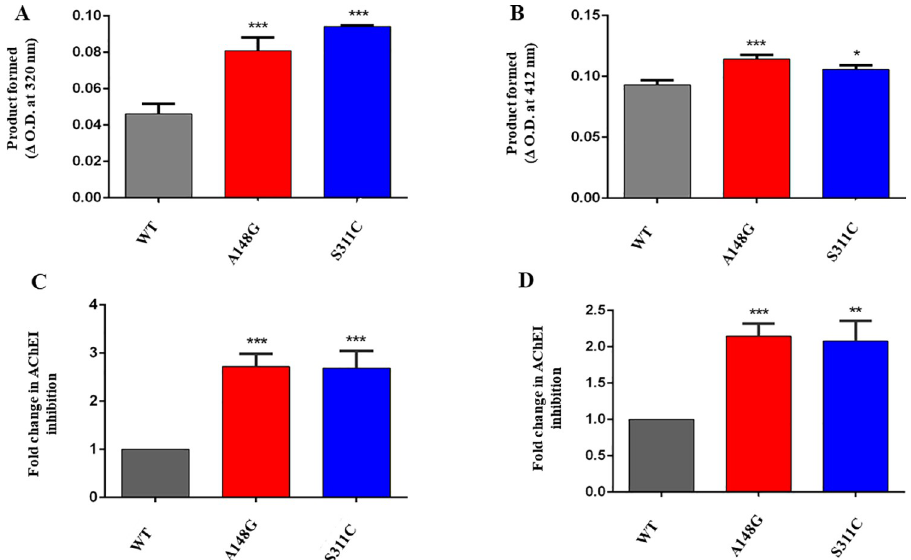
Fig 6. Comparative activities of HuPON2-WT and polymorphic site mutants and corresponding inhibition of selected AChEIs. A. Esterase activity of HuPON2-WT compared with polymorphic site mutants, B. Lactonase activity of HuPON2-WT compared with polymorphic site mutants. The catalytic activity was followed in intervals ranging from 0 to 30 minutes. The activities were reported as product formed in terms of initial and final absorbance measured. Inhibition of AChEI by polymorphic HuPON2. C. DHC and D. PB in the presence of purified HuPON2-WT and polymorphic site mutant proteins. The wells without HuPON2 protein were used as control. AChEI drug inhibition was reported as a fold change to WT. Results are the average of triplicates and error bars show the standard deviation.